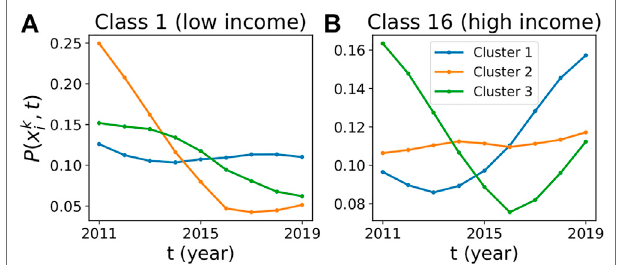
FIGURE2| Averagetemporalevolutionoftheabundanceofhouseholds within the lowest and highest income. Temporal evolution of centroids after performingak-means clusteringon thenormalized abundance ofhouseholds with category k , P ( x k i , t ) , as a function of time t for the lower (A) and higher (B) income